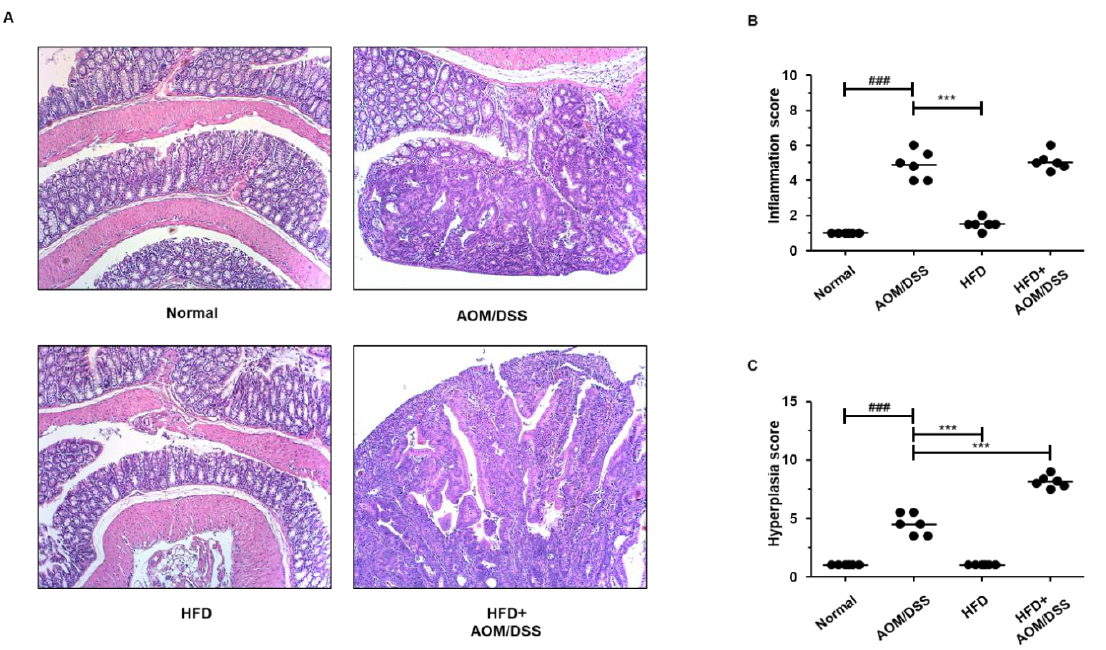
Figure 2. E ff ects of HFD on the histological analysis in the AOM / DSS-induced CAC mice model. ( A ) A representative portion of the colon tissues was stained by H&E (original magnification, 100 × ). ( B ) The inflammation score and ( C ) hyperplasia score were estimated. The values are the mean ± SD ( n = 10); ### p < 0.001 vs. normal group; *** p < 0.001 vs. the AOM / DSS group; significant di ff erences between the treated groups were determined by ANOVA and Dunnett’s post-hoc test. Table 3. Histological parameters of distal colon for assessment of neoplasm.